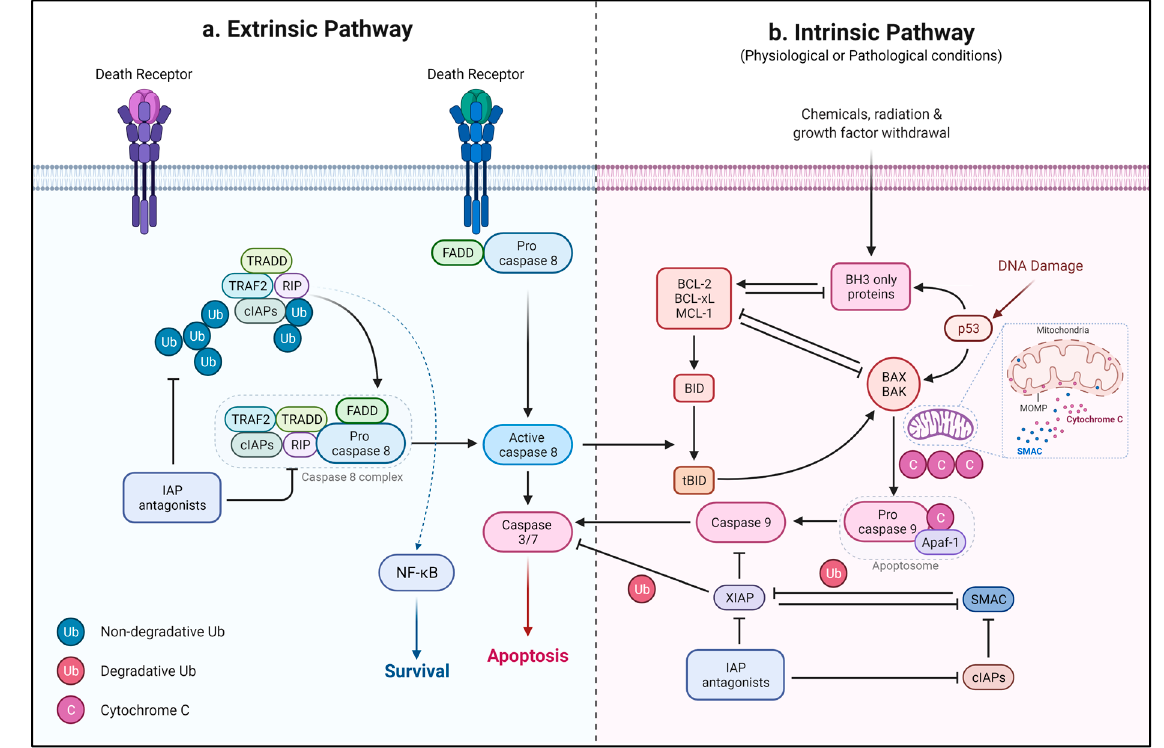
Figure 4. Extrinsic and intrinsic pathways of apoptosis. ( a ) Extrinsic pathway: following an external death signal, death receptors are activated by oligomerization, leading to a cascade of caspase activation and apoptosis. ( b ) Intrinsic pathway: several internal stimuli can activate the intrinsic apoptotic pathway, including chemicals, radiation, growth factor withdrawal, and genotoxic insults. The illustration is created with BioRender.com. BCL-2: B-cell lymphoma 2; BCL-xL: B-cell lymphoma-extra large; MCL-1: myeloid cell leukemia 1; BAX: Bcl-2-associated X protein; BAK: Bcl-2 antagonist/killer; BID: BH3 interacting-domain death agonist; tBID: truncated BID; XIAP: X-linked inhibitor of apoptosis protein; SMAC: second mitochondrial ‐ derived activator of caspases; cIAPs: cellular inhibitor of apoptosis proteins; FADD: Fas ‐ associated death domain protein; TRADD: TNF ‐ receptor ‐ associated death domain; TRAF2: TNF ‐ receptor ‐ associated factor 2; RIP: receptor ‐ interacting protein; NF ‐κ B: nuclear factor kappaB.